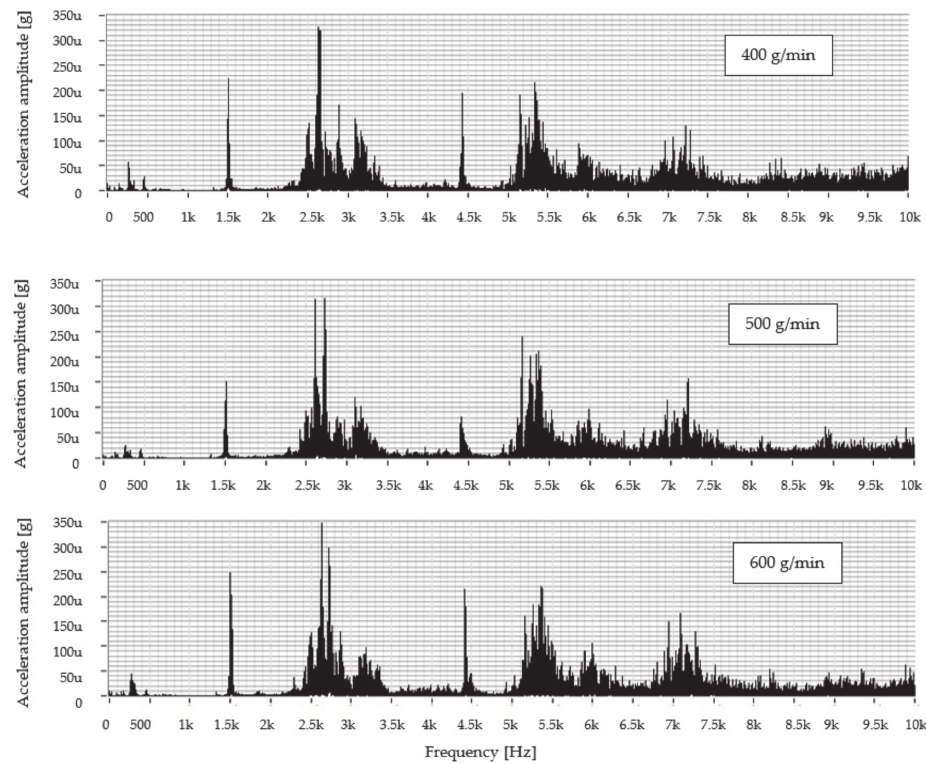
Figure 5. Frequency spectra of vibration acceleration amplitude versus frequency for abrasive mass flows at a feed rate of 100 mm/min for abrasive